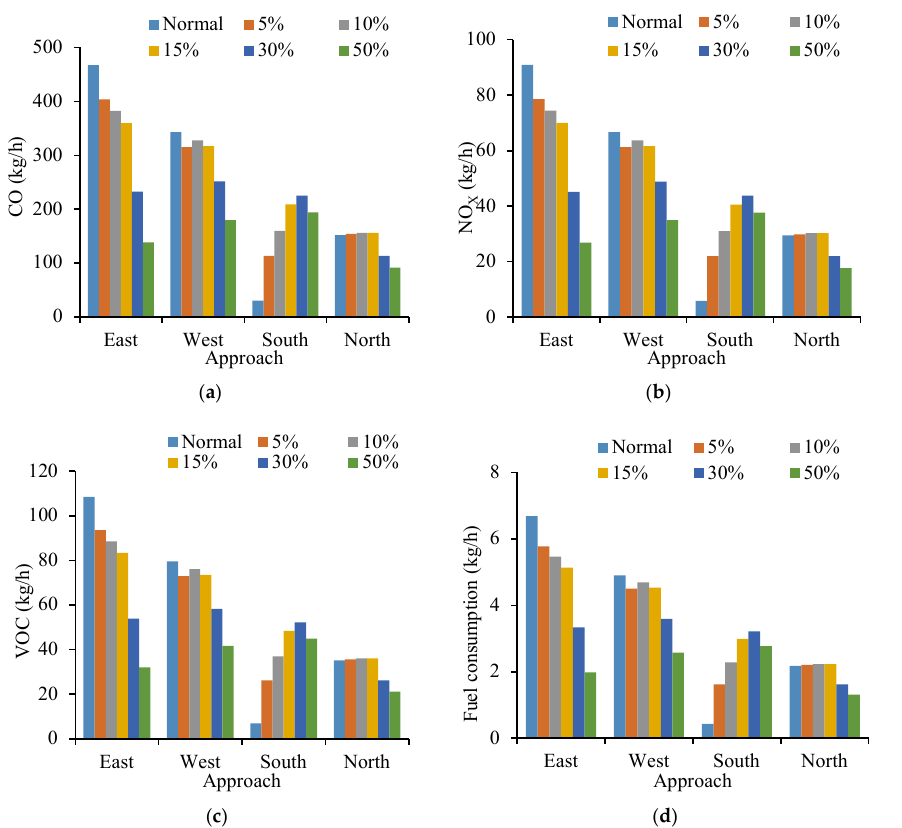
Figure 19. Comparison of No. 3 intersection emission. ( a ) Comparison of CO emission under different approaches at No. 3 intersection. ( b ) Comparison of NO X emission under different approaches at No. 3 intersection. ( c ) Comparison of VOC emission under different approaches at No. 3 intersection. ( d ) Comparison of fuel consumption under different approaches at No. 3 intersection.